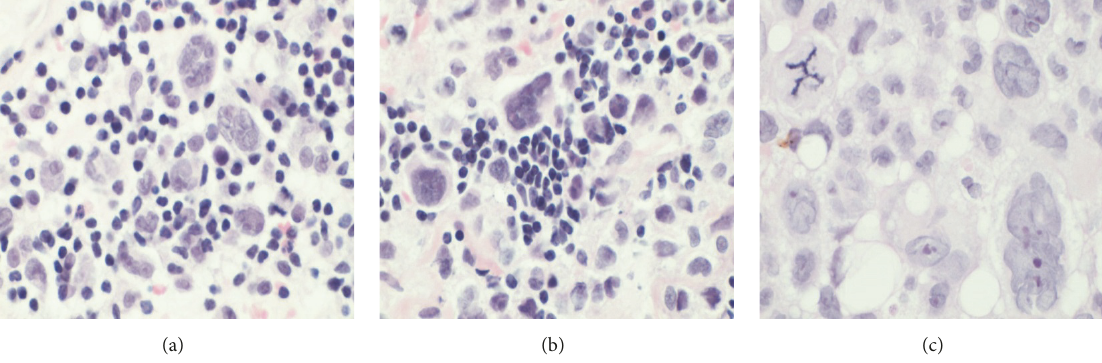
Figure 2: High power H&E images demonstrating variable inflammatory infiltrate surrounding neoplastic tumour cells in each of the three biopsies (a), (b), and